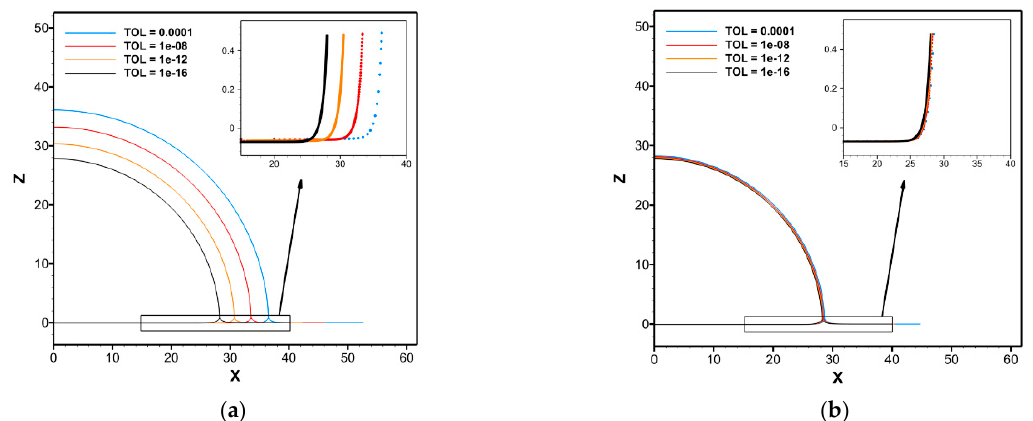
Figure 3. Comparison of the bubble shapes obtained according to the tolerance of the ODE solver